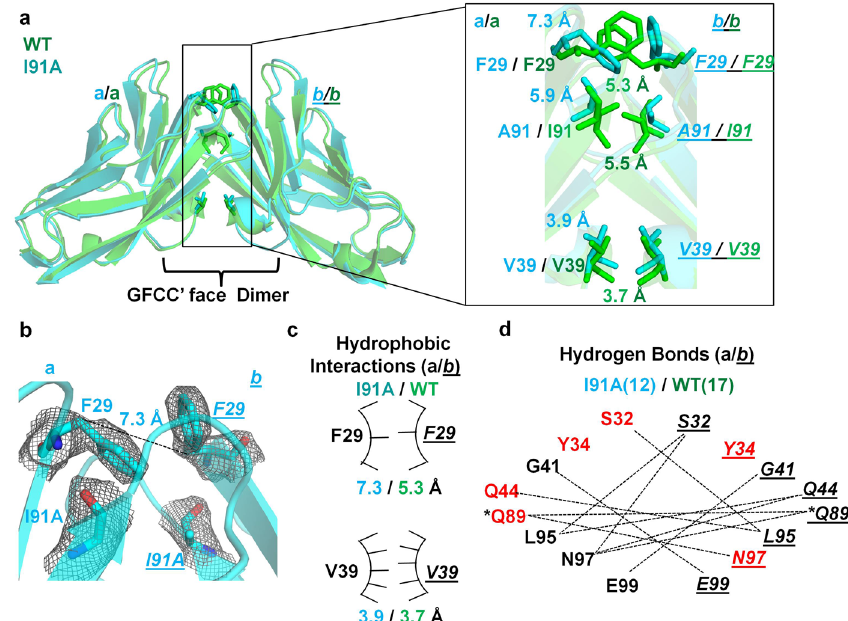
Fig. 3 Crystal structure I91A IgV mutant of hCEACAM1. a The ribbon diagram of the I91A mutant (cyan) and WT (green) crystal structures with molecules (a) and ( b ) superimposed on each other. The inset shows residues of molecule (a) and ( b ) by stick representation and superimposition of F29, V39, and A91 residues of the I9AA mutant (cyan) on F29, V39, and I91 residues of the WT (green), where distances between the β carbons of the labeled are shown in cyan and green, respectively for I91A mutant and WT. b The stick representation of I91A and F29 residues of molecules (a) and ( b ) with electron densities (2Fo – Fc map at 1.0 σ level) as observed in the I91A mutant structure. The hydrogen bond (7.31 Å) between β carbons of F29 residues as observed in the I91A mutant is shown by dashed lines. The carbon atoms in cyan, carbonyl oxygen in red and nitrogen in blue, are colored, respectively. c The arc/stick representation of hydrophobic interactions with distance between β carbons of labeled residues of molecules (a) and ( b ) as observed in the I91A crystal structure (cyan) compared to the WT (green). The residues of molecule b are shown in italics and underlined, respectively. The weaker hydrophobic interactions mediated between two F29 residues are shown by fewer pointers on the hydrophobic arc relative to WT. d The hydrogen bonded interactions (dashed lines) mediated by GFCC ′ face labeled residues as observed in the I91A mutant structure. The lesser quantity of hydrogen bonds at GFCC ′ interface were observed in the I91A mutant structure, 12 (cyan) vs 17 (green) for I91A and WT, respectively. The residues of molecules (a) and ( b ) are shown in bold and italics underlined, respectively. The residues in red indicate loss or decreased number of hydrogen bond interactions in the I91A compared to WT and asterisk (*) indicates two hydrogen bonds mediated by Q89 as described in Fig.